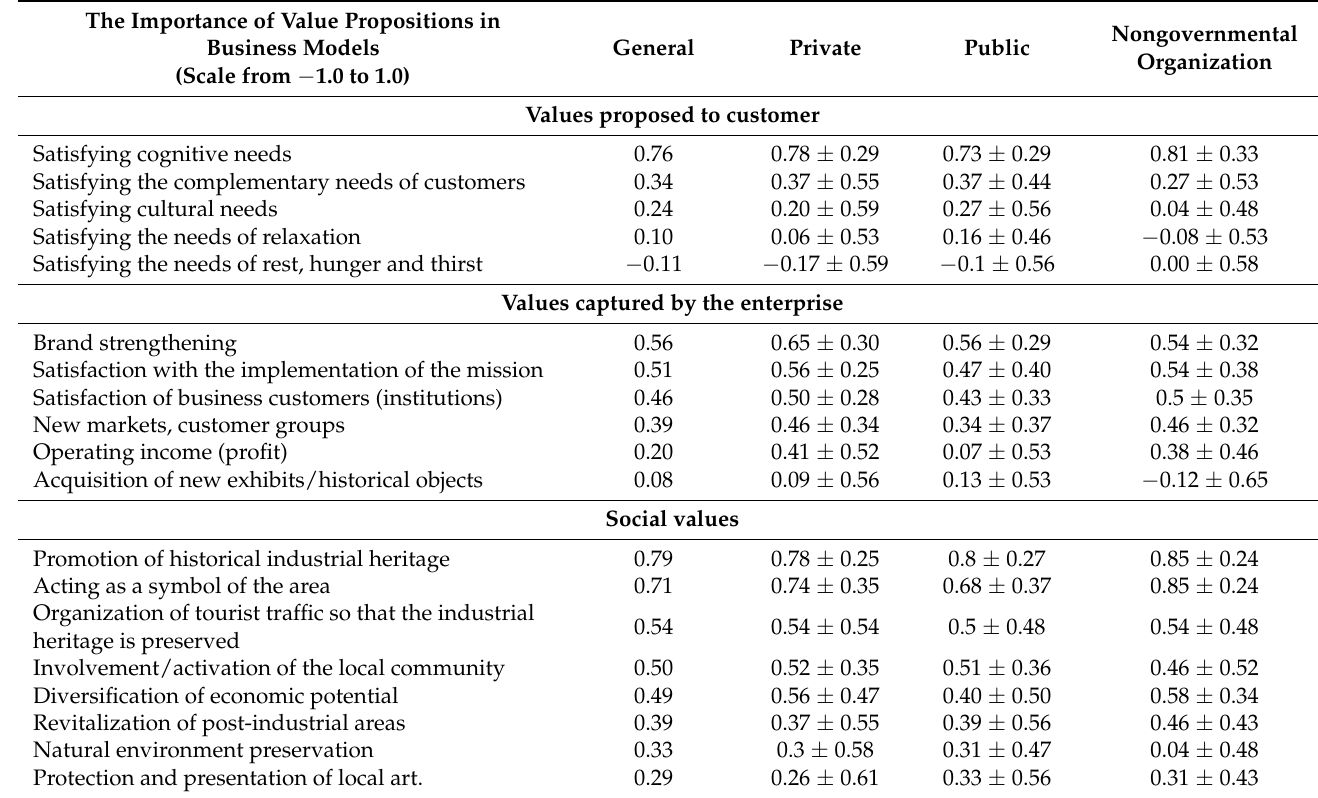
Table 1. The importance of value propositions in the business models of heritage tourism